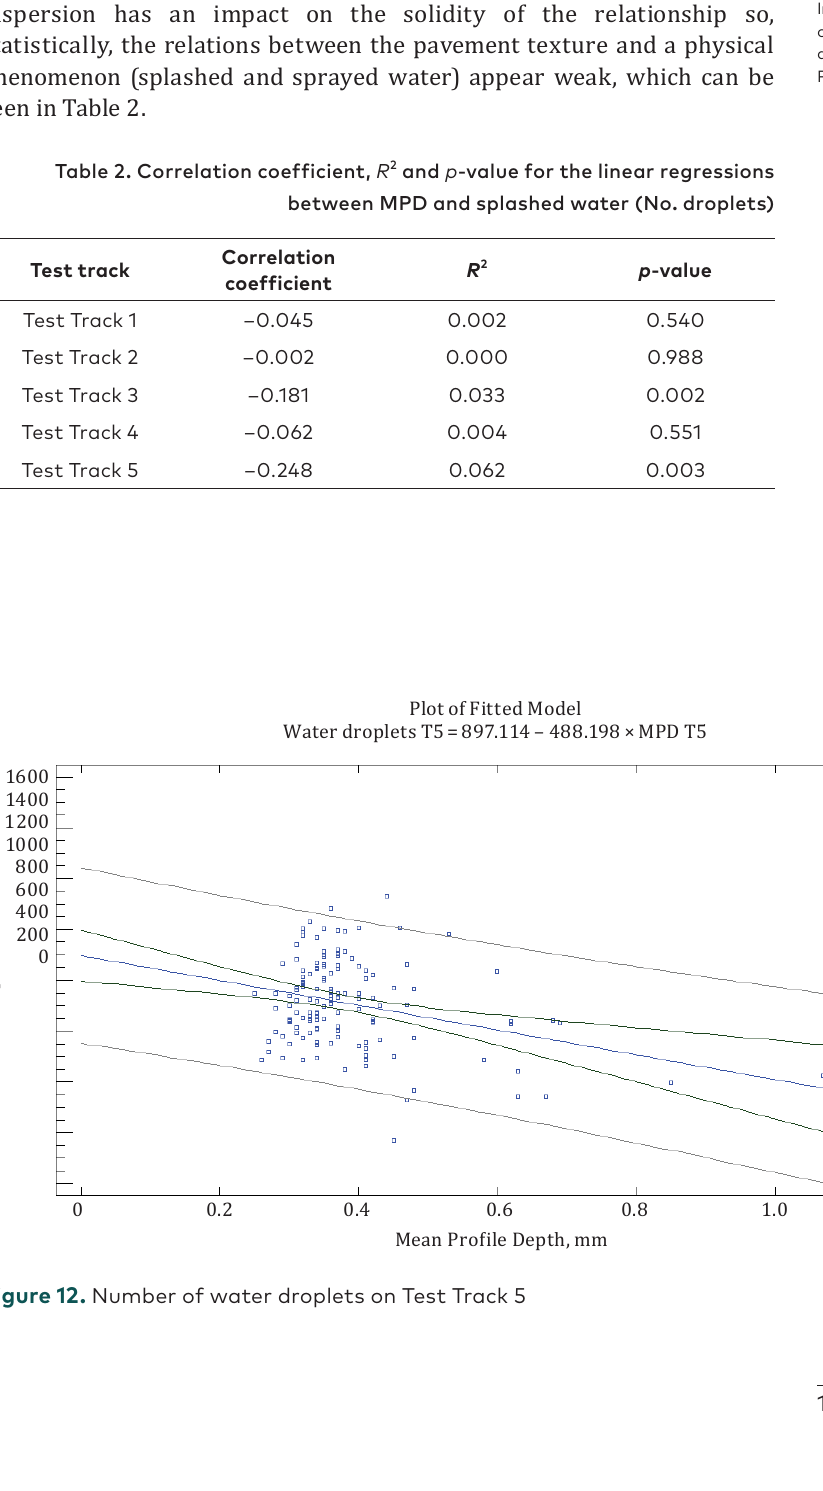
Figure 12. Number of water droplets on Test Track 5